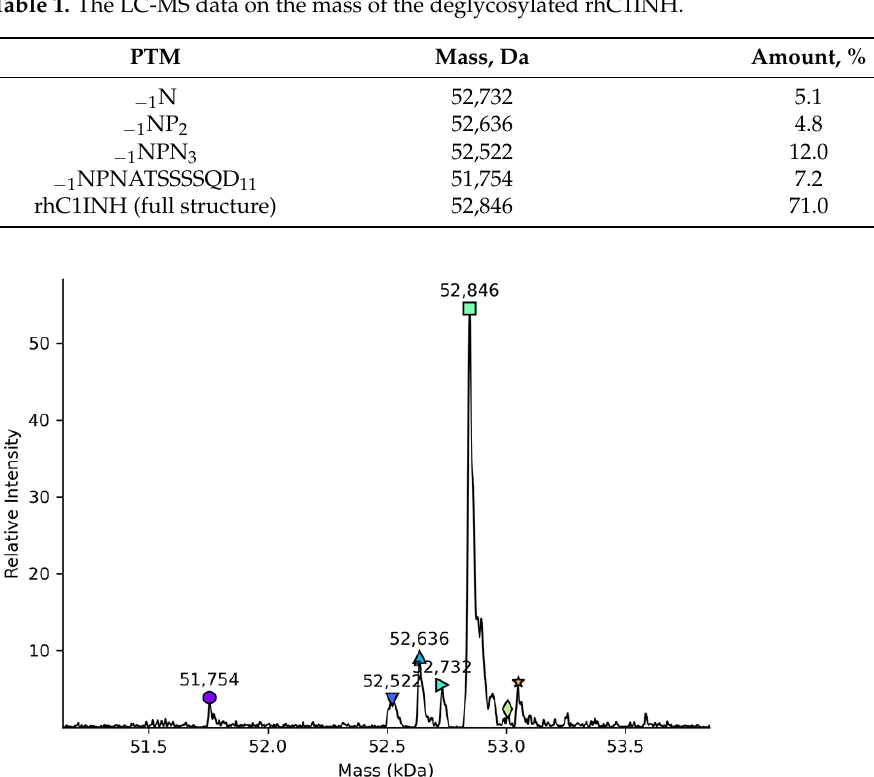
Figure 1. Mass-spectrometry data of the total deglycosylated variants of rhC1INH mass distribution. The integrated peaks are designated by colorful symbols of different shapes.